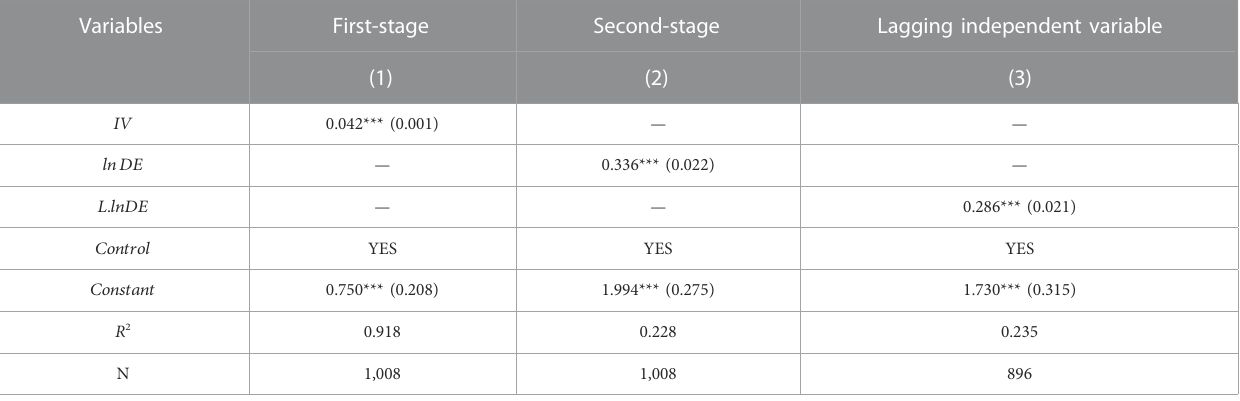
TABLE 9 Endogenous test